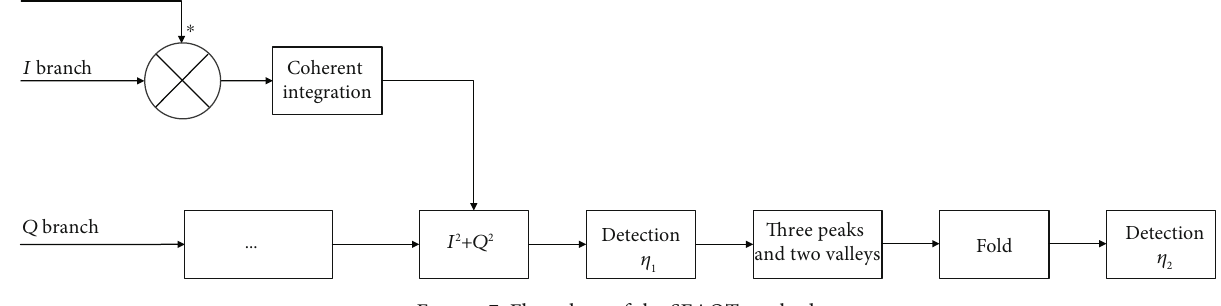
Figure 7: Flow chart of the SEAQT method.